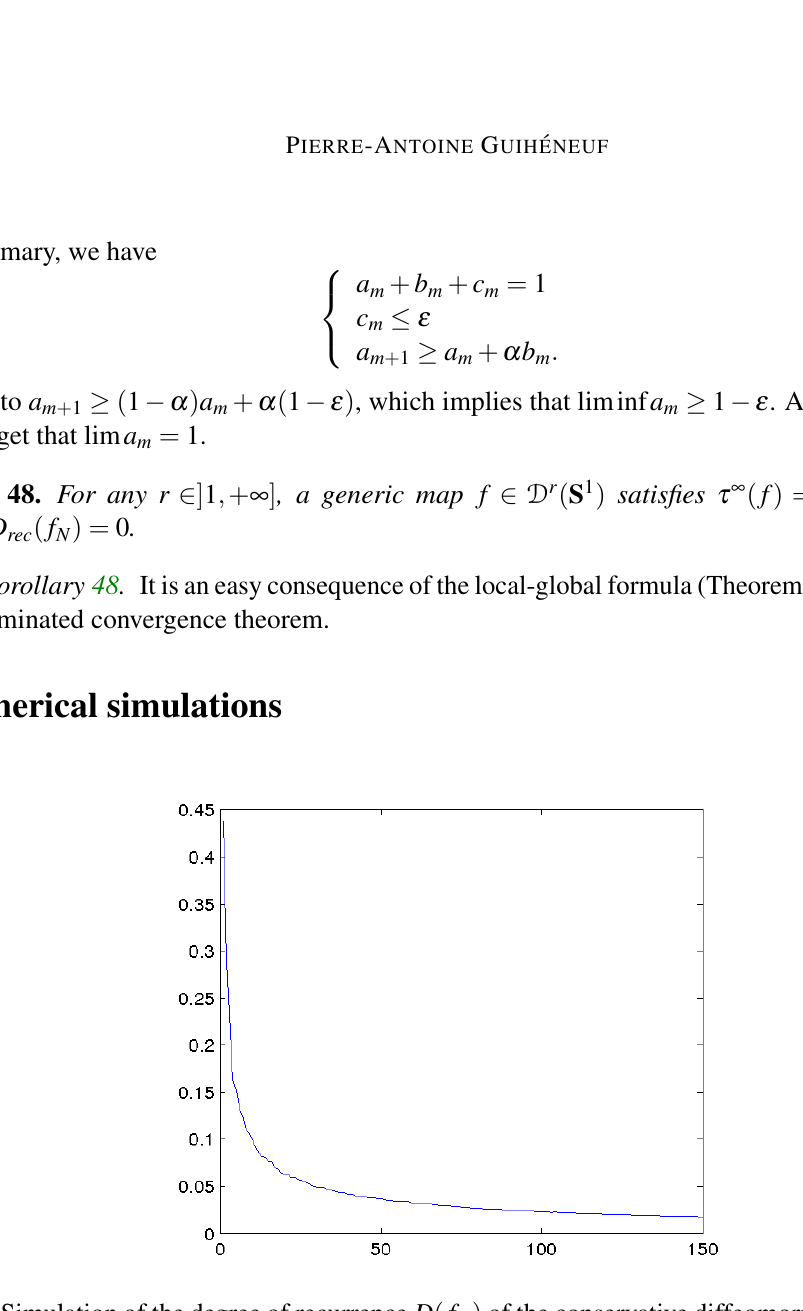
Figure 12: Simulation of the degree of recurrence D ( f N ) of the conservative diffeomorphism f , depending on N , on the grids E N with N = 128 k , k = 1 , ··· ,